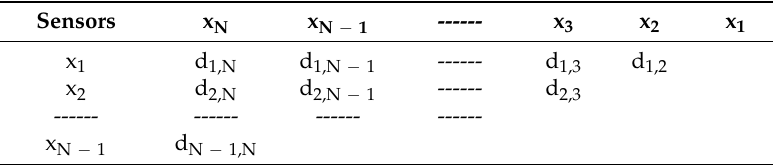
Table 1. Euclidean distance between sensor nodes in one direction.